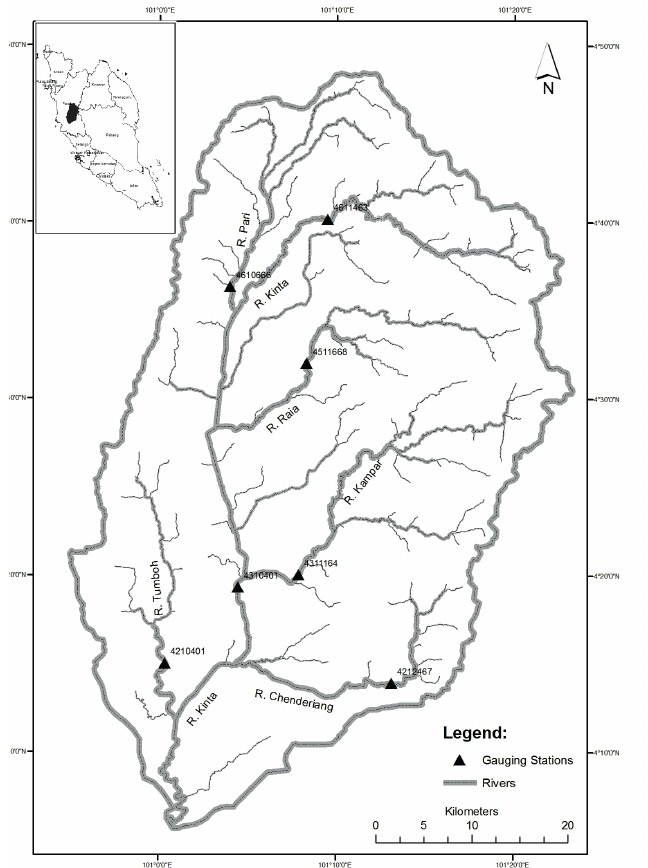
Fig. 1 Kinta River and its main tributaries showing the gauging